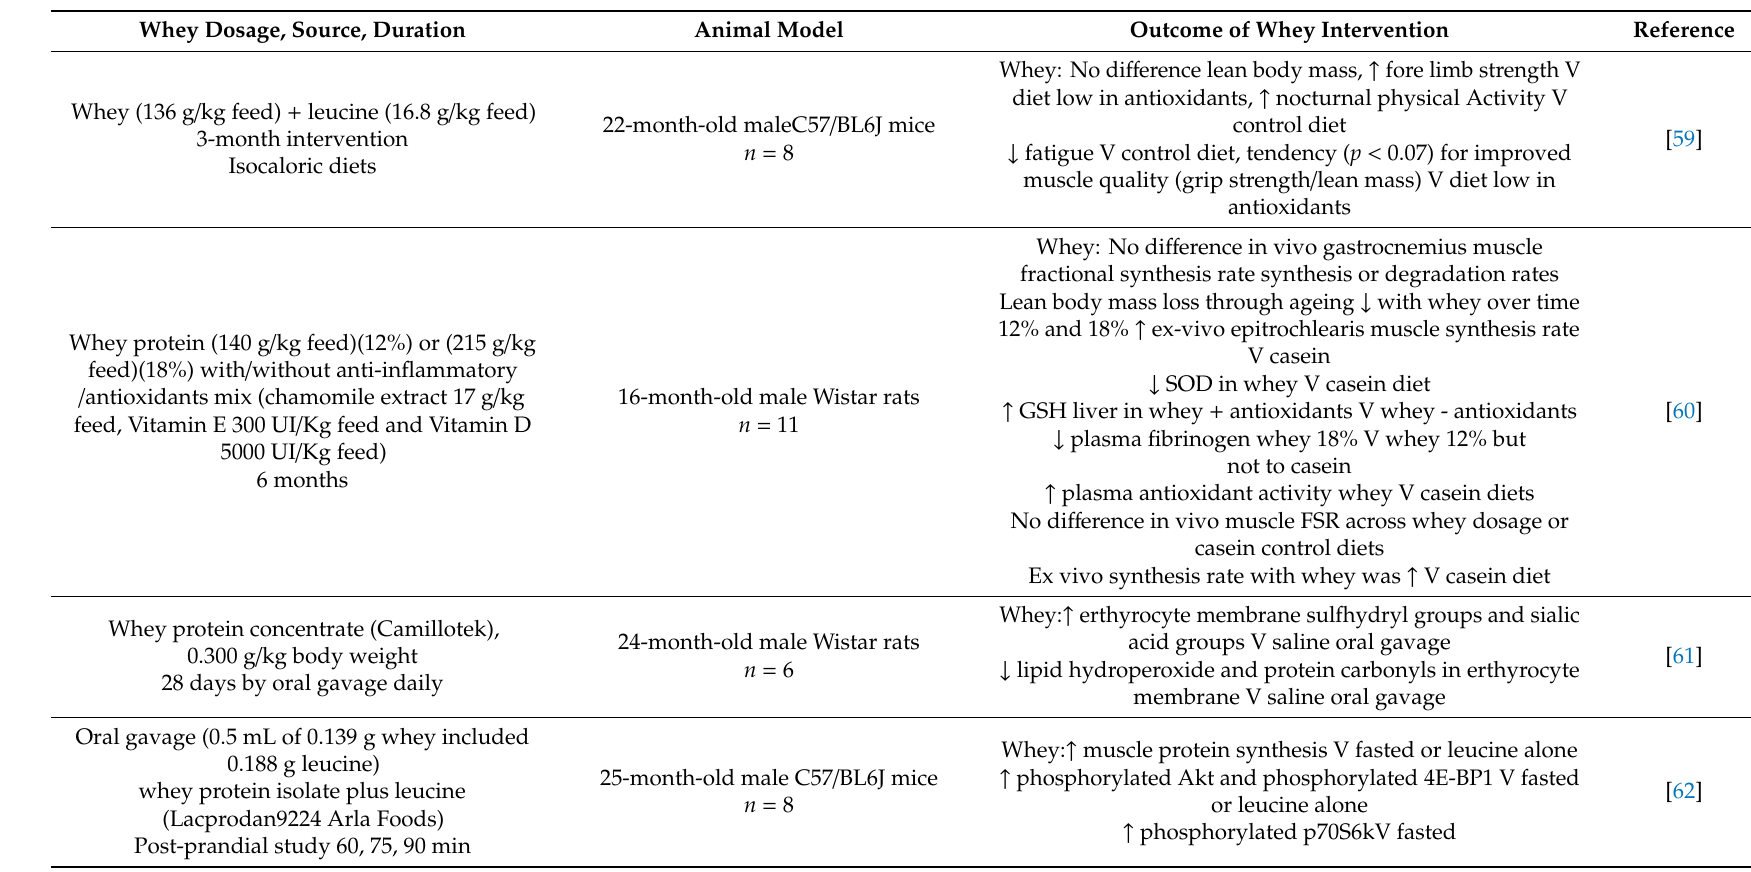
Table 2. Aged animal intervention trials outlining the e ff ects of whey supplementation. SOD: superoxidase dismutase; GSH: glutathione;FSR: fractional synthesis rate; Akt: protein kinase B; FFM: fat free